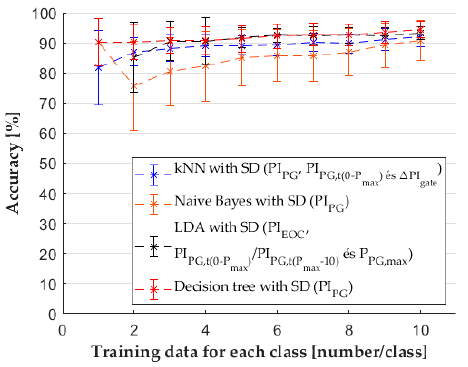
Figure 14. Comparison of classifiers with features chosen by the SFS method.